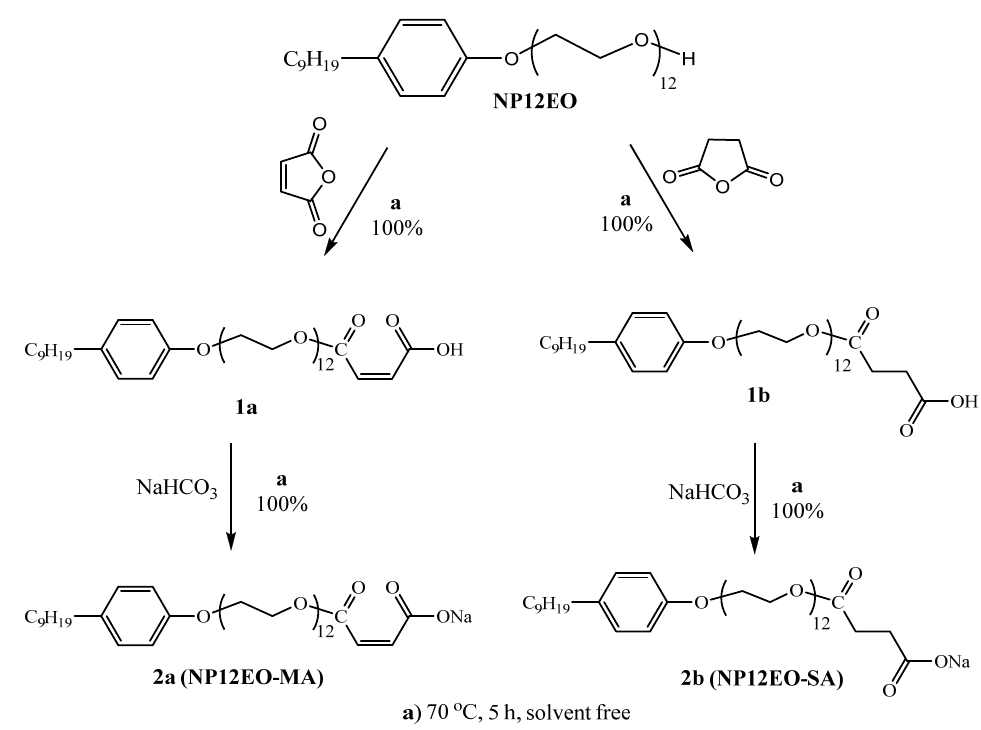
Scheme 1. Synthesis of NP12EO-MA and